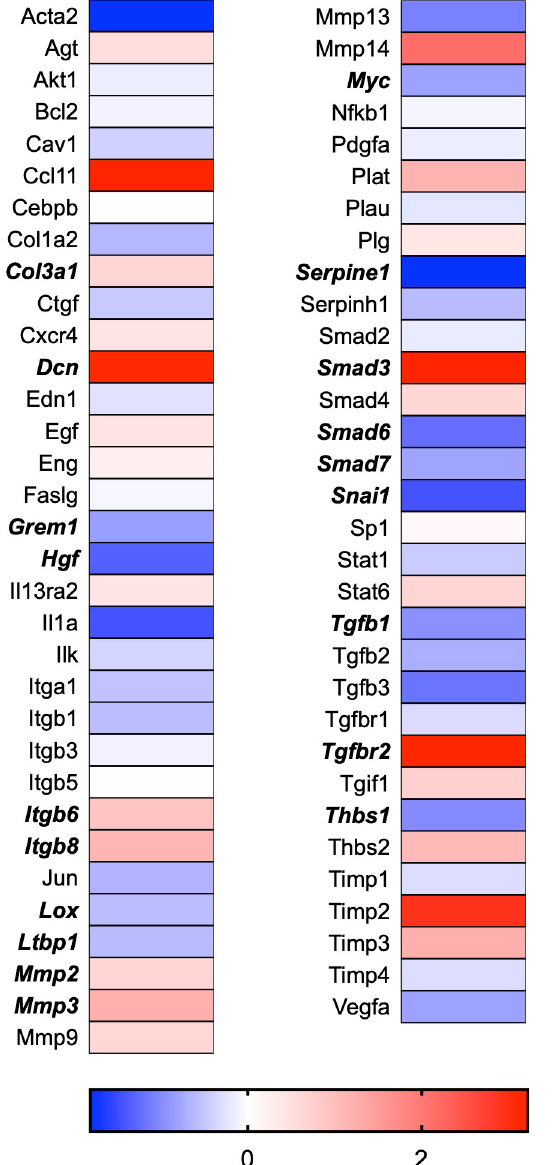
Fig 8. Fibrosis heat map. Bold text indicates significantly altered gene